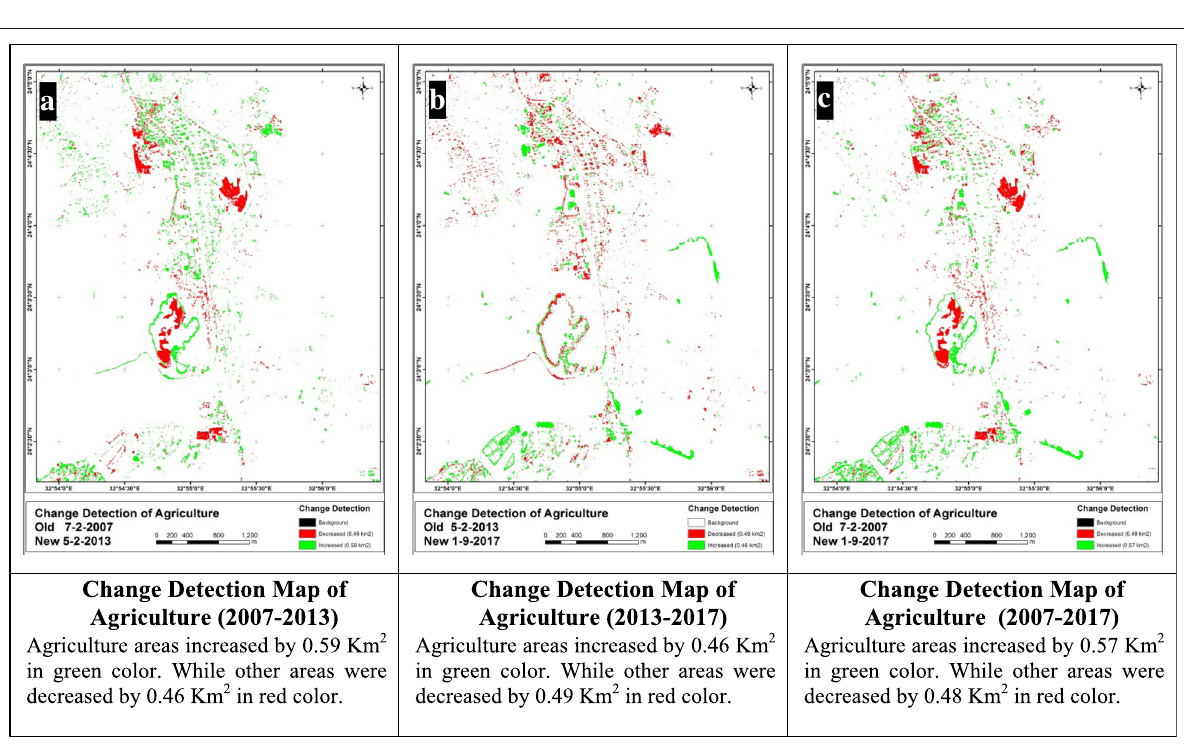
Fig. 10 Change detections of agriculture areas during the period of 2007-2017 in study area a Change Detection Map of Agriculture (2007-2013), b Change Detection Map of Agriculture (2013-2017) and c Change Detection Map of Agriculture